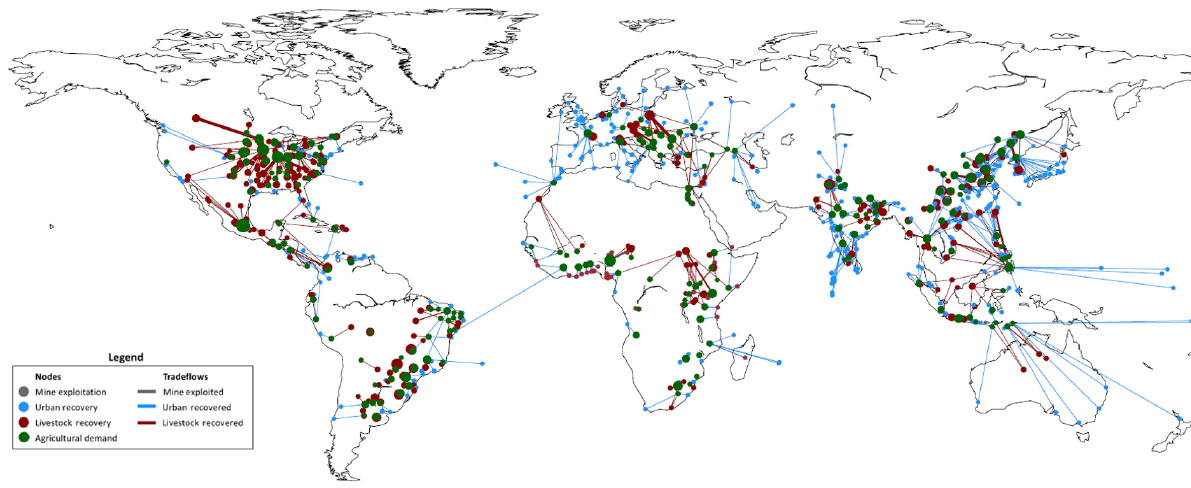
Figure 6. Phosphorus trade network for trade in recycled P only (scenario 3) at determined phosphorus market prices of 5700USDt − 1 with 7.92Mt being traded. All of this trade is sustainable but is only able to accommodate 41% of demand.